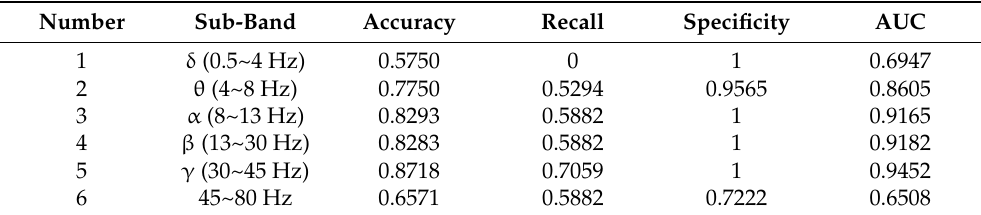
Table 4. EEG microstate parameters (frequency of occurrence, average duration, and proportion of time) and SVM classifier results.